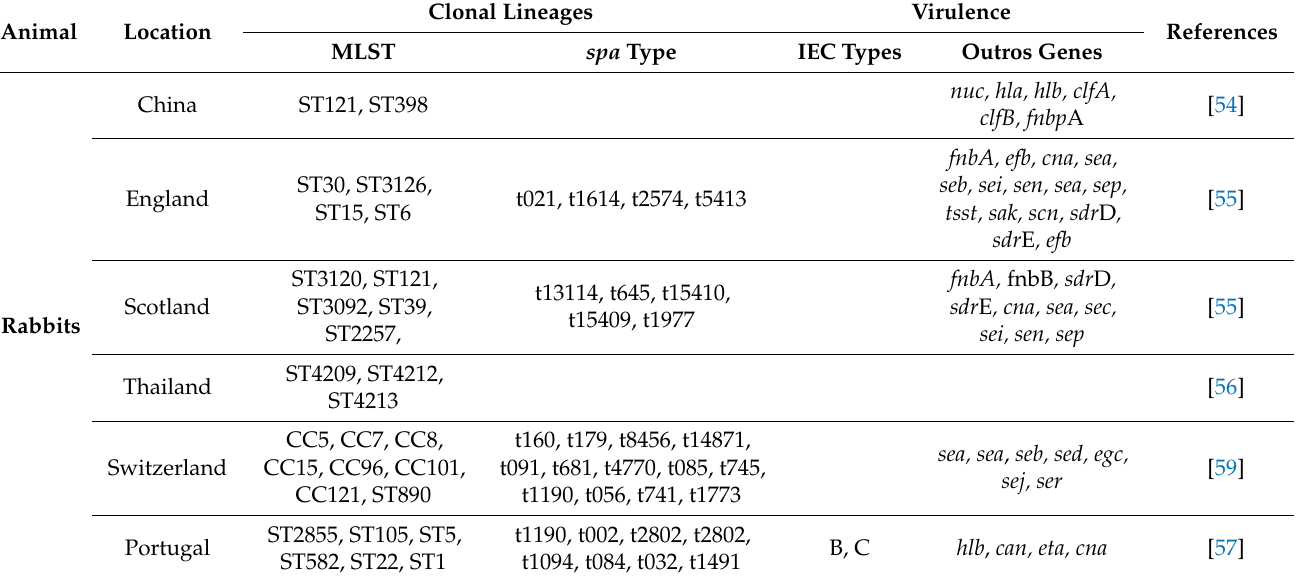
Table 3. Molecular characteristics of LA-MRSA clones in different continents